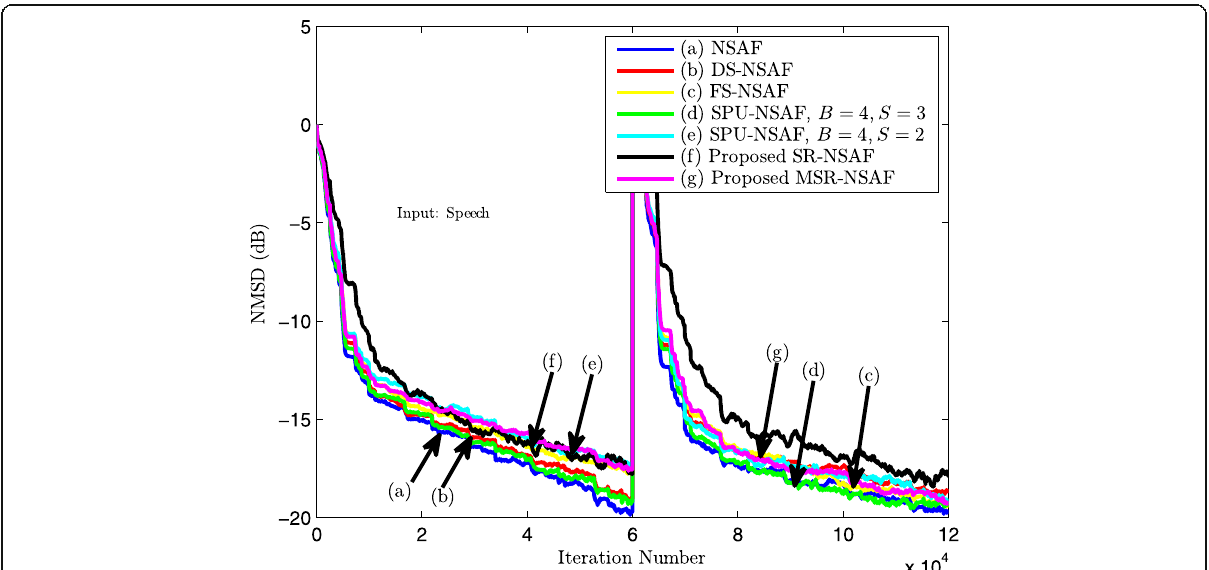
Fig. 12 NMSD learning curves for tracking performance of NSAF, DS-NSAF, FS-NSAF, SPU-NSAF, SR-NSAF, and MSR-NSAF with N =4. Exact-modeling scenario, speech input signal. Echo path changes at a certain